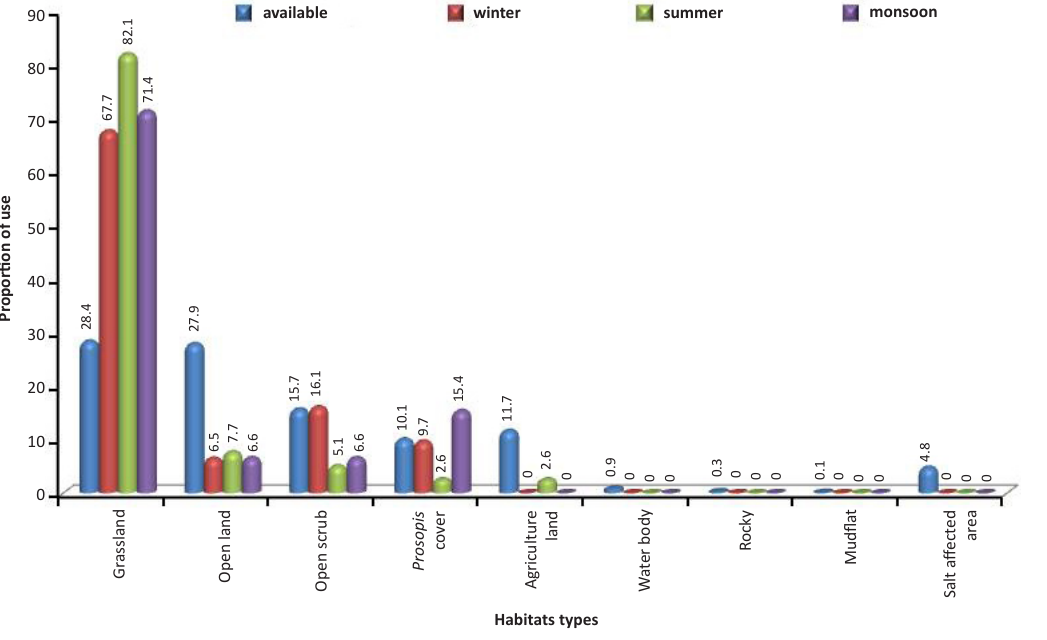
Figure 3. Proportional seasonal use of various habitats by GIB observed in its distribution range in Gujarat